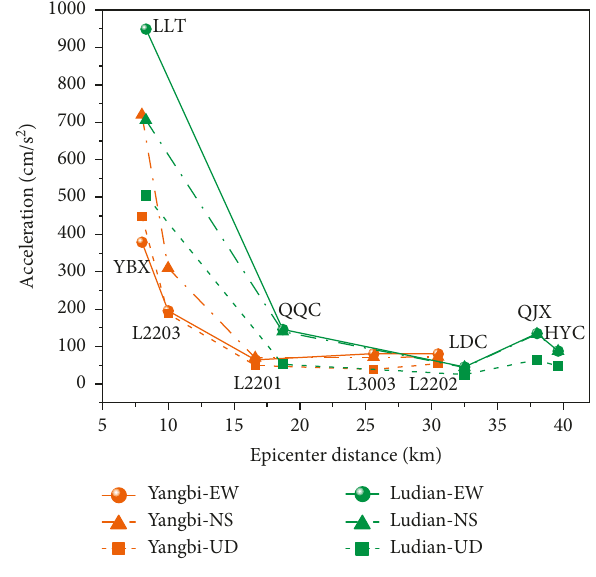
Figure 11: Attenuation of the PGA. Table 2: Duration of strong